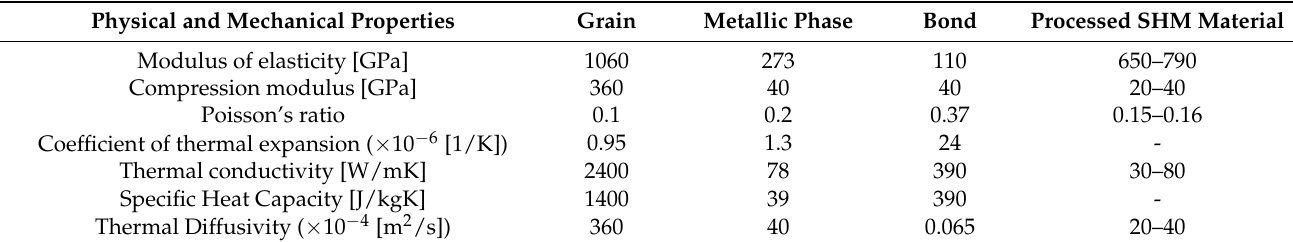
Table 2. Physical properties of the grain–metallic phase–bond-processed SHM material system.